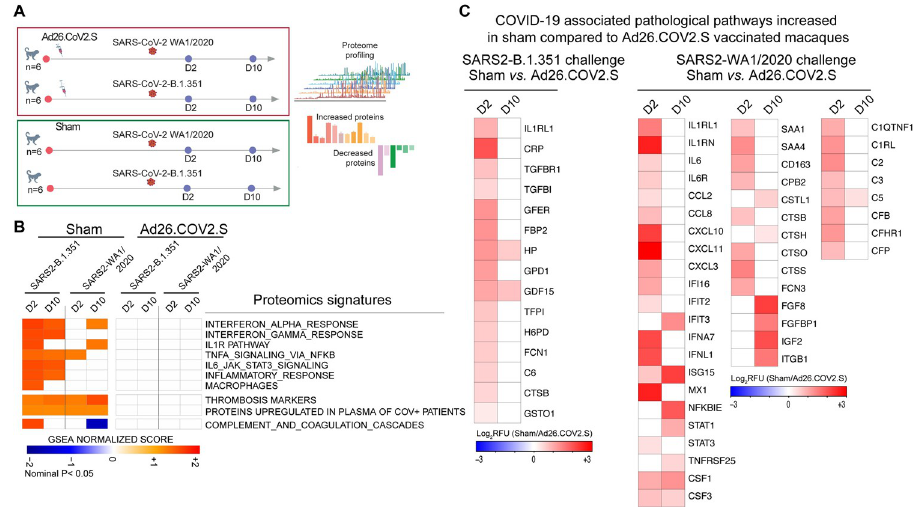
Fig 4. Ad26.COV2.S vaccination attenuates proteomics signatures of inflammation and thrombosis pathways in rhesus macaques challenged with SARS2 WA1/2020 or B.1.351. ( A ) Study design. ( B ) Heatmap representation of the GSEA normalized enrichment score (NES) of pathways of inflammation, thrombosis, and the coagulation cascades in sham or Ad26.COV2.S vaccinated macaques at days 2 and 10 following challenge with WA1/2020 or with B.1.351. NES scores raging from blue (decreased), white (not significant), or red (increased) in sham unvaccinated compared to vaccinated macaques. ( C ) Heatmap representation of the log2 fold change of selected increased proteins in serum of sham unvaccinated compared with vaccinated macaques, for macaques challenged with the B.1.351 variant (left panel) or with the WA1/2020 challenge (right panel). Values represent the relative fluorescence unit (RFU) levels of each individual protein, ranging from blue (decreased), white (not significant), or red